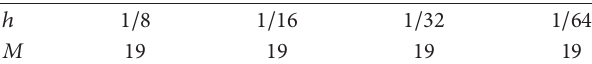
Table 4: The iteration counter 𝑀 versus the grid size ℎ for both the parallel Robin-Robin domain decomposition method with BJS interface